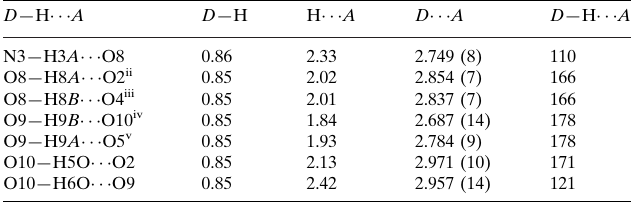
Hydrogen-bond geometry (A˚ , (cid:3)